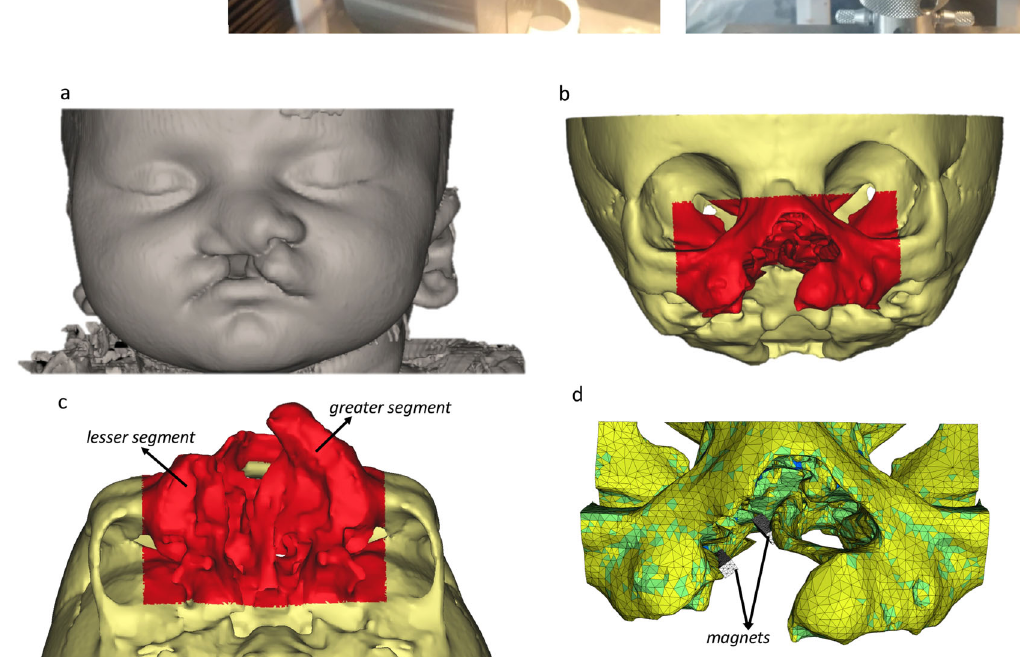
Fig. 2 From CT scan to FE-model. a The 3D reconstructions of the soft and hard tissues, b Frontal view of the region of interest for the FE model c Palatal view of the region of interest for the FE model d and the FE model of the dental magnet partially